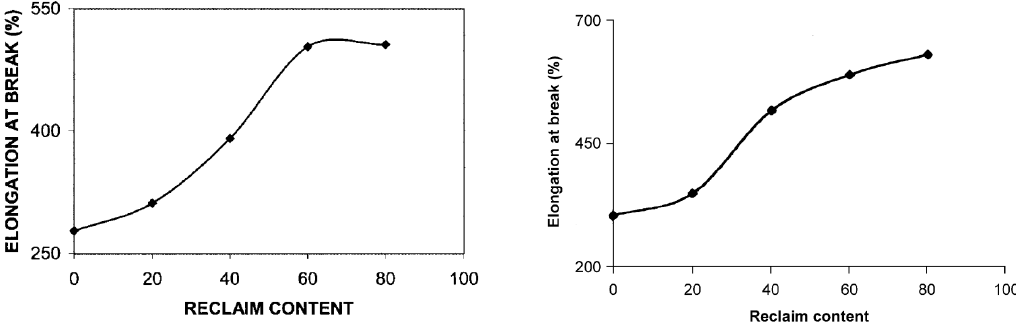
Figure 26. Elongation at break as a function of reclaim rubber content for acrylonitrile butadiene rubber (NBR) (left) and styrene butadiene rubber (SBR) (right) compounds (reproduced with permission from [116,117]).